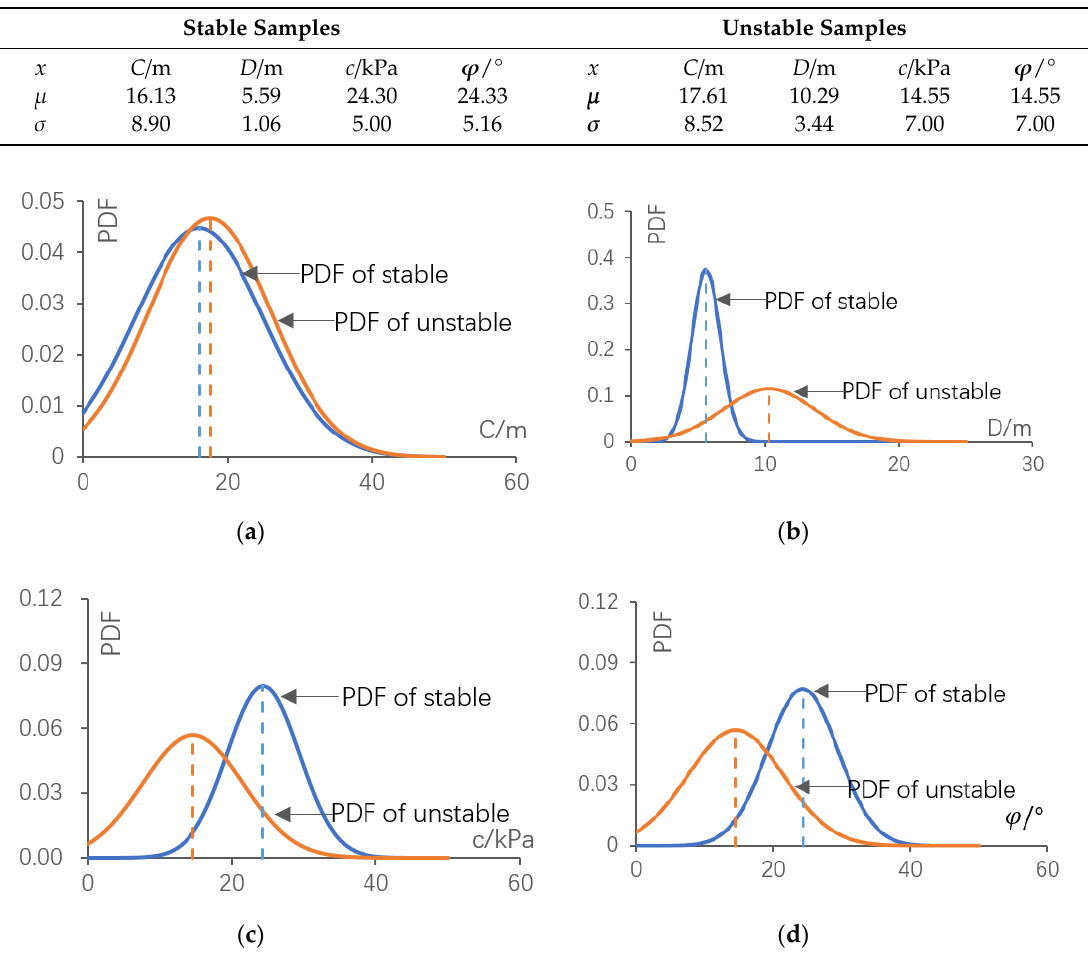
Figure 9. Updated PDFs of features with extra stable samples: ( a ) the cover depth; ( b ) the diameter; ( c ) the cohesive strength; ( d ) the friction angle.